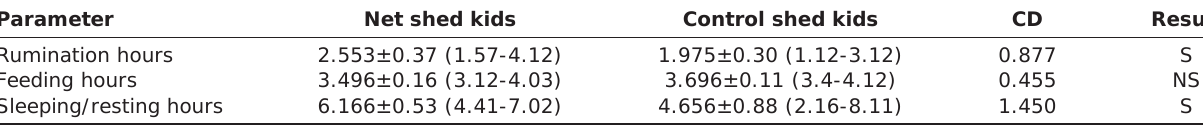
Table-11: Behavioral parameters in kids under net and control